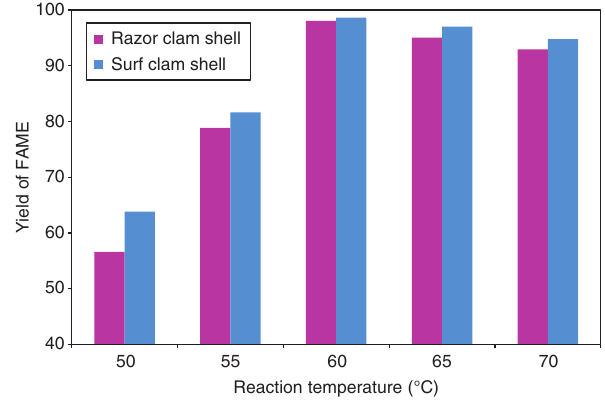
Figure 8: Effect of reaction temperature on % yield of fatty acid methyl ester (FAME) (catalyst bed length 250 mm, residence time 1.5 h, and methanol/oil molar ratio